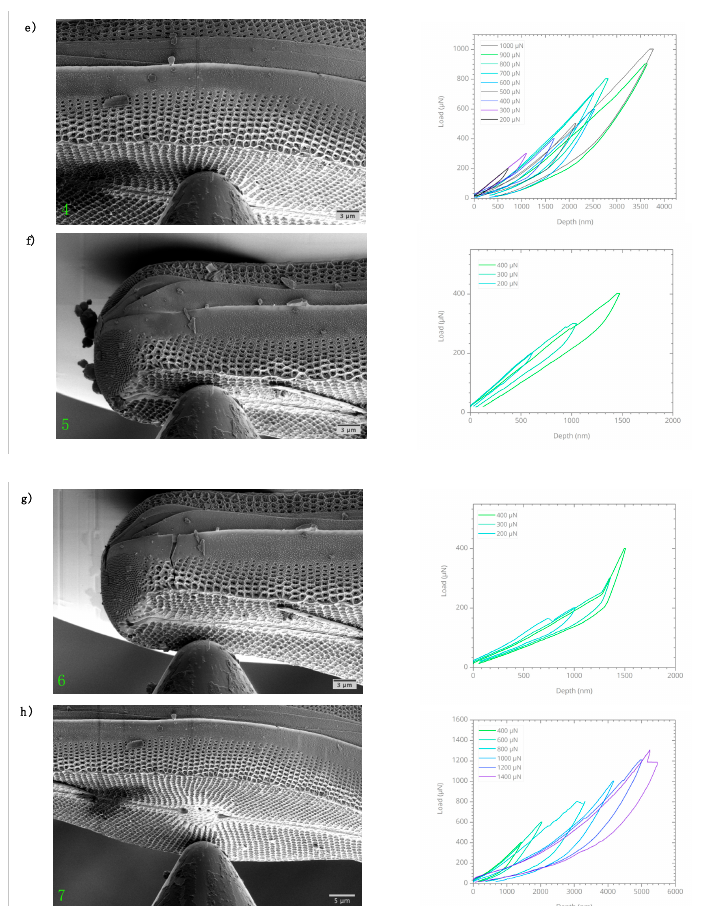
Figure 6. In situ micro-indentation experiments were conducted at seven different locations on the epivalve of Didymosphenia geminata frustule sample. ( a ) overview of the micro-indentation spots, ( b – h ) The micro-indentation spots and the obtained load-displacement curves.